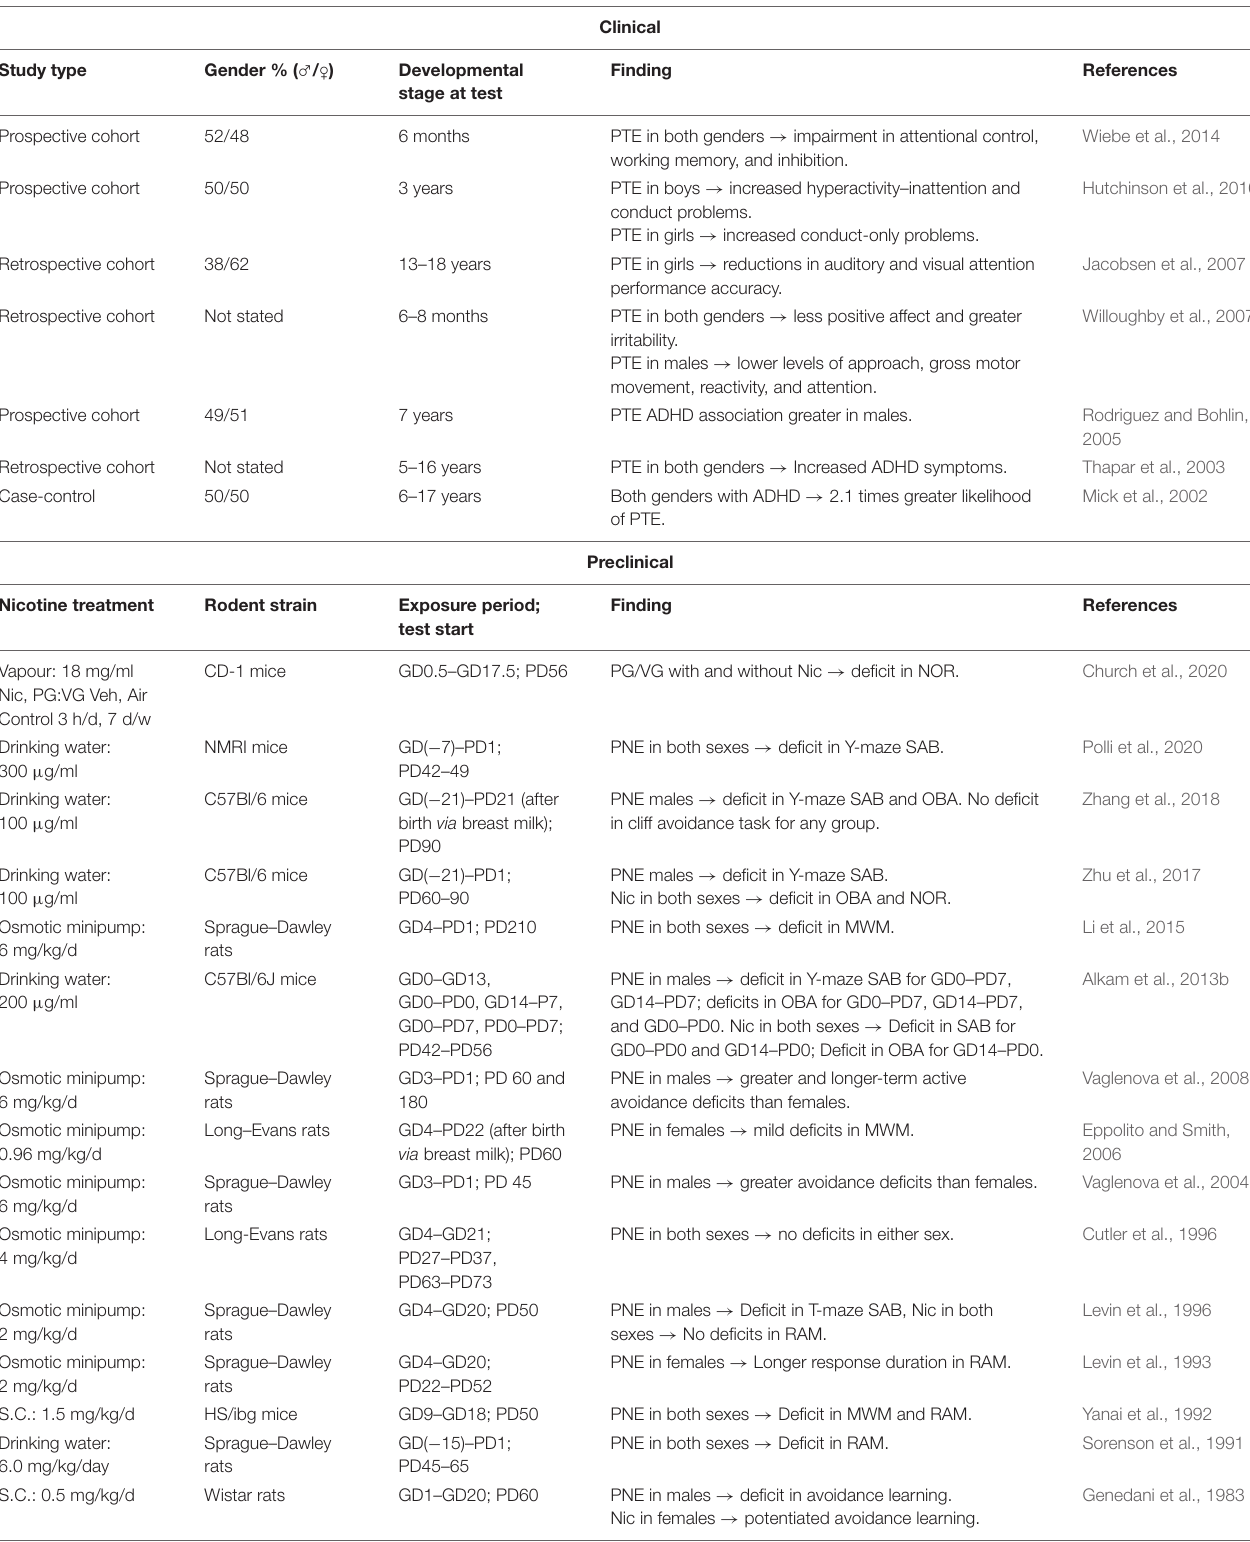
TABLE 1 | Summary of cognitive findings in clinical and preclinical